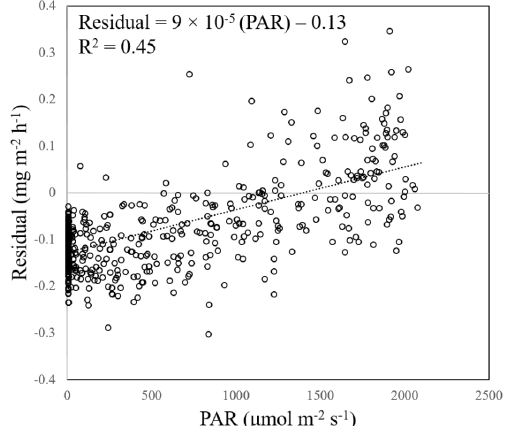
Figure 10. Plot of the residual values from the temperature-only monoterpene emission model against PAR, demonstrating that light as well as temperature has a significant impact on monoterpene